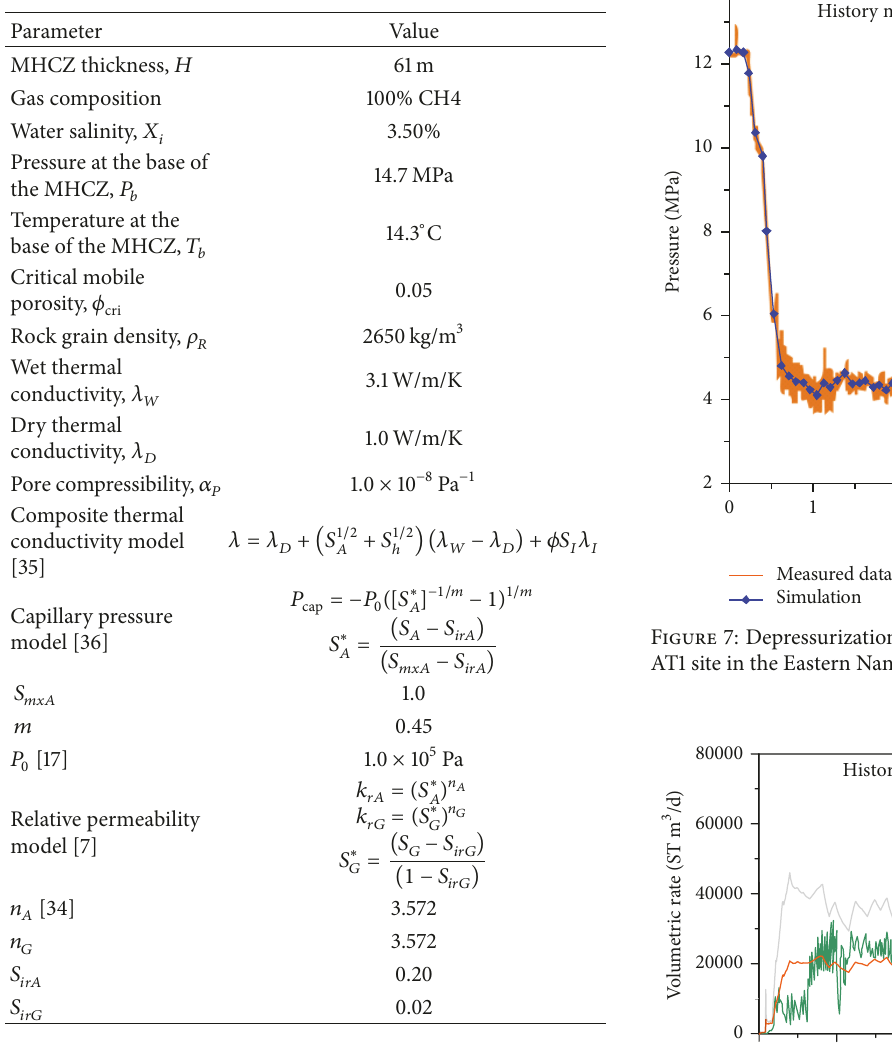
Table 1: Hydrate deposit properties at the AT1 site.